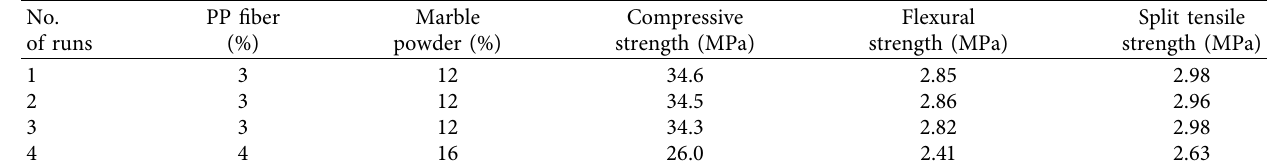
Table 7: Optimization of the